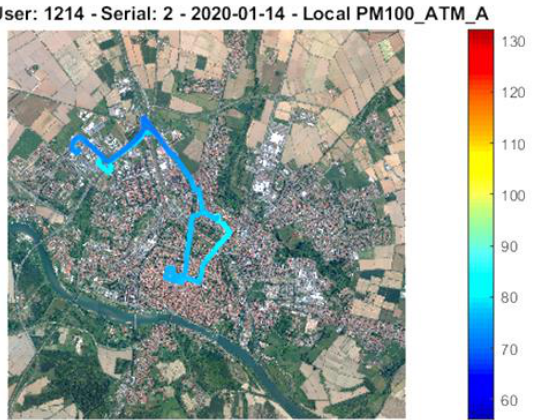
Figure 18. The track coloured according to the local and instantaneous values of